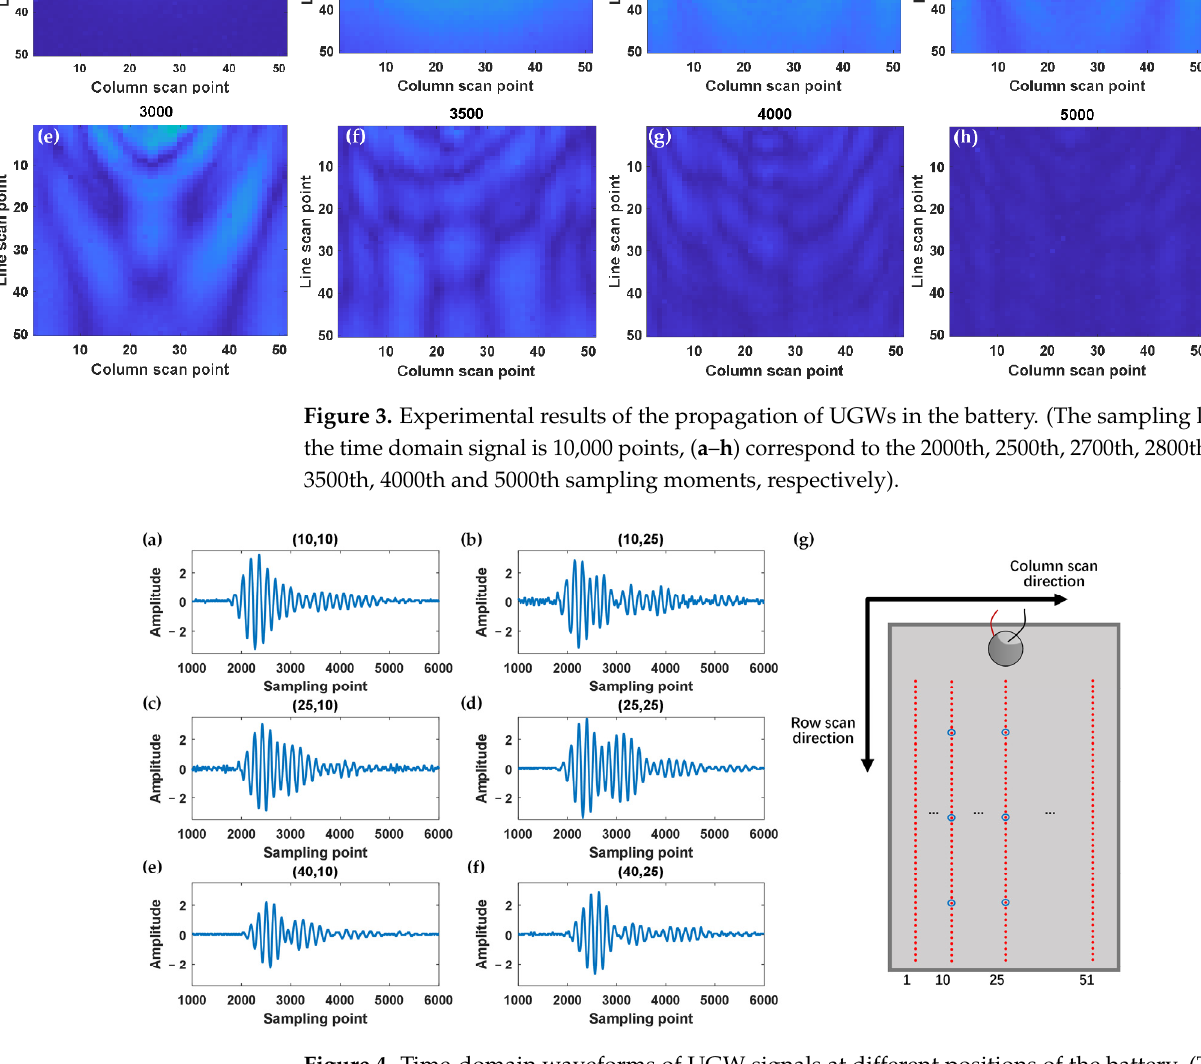
Figure 5. Energy spectrum of surface scanning UGW signal of lithium-ion battery. 4.2. Comparative Analysis of UGW Scanning Results of Different Battery SOC By scanning the B2 battery, several “point” parameters are extracted from the one- dimensional UGW time domain signal. Then the relationship between “point” parameters and battery SOC is analyzed. Figure 6 shows the results of the time-domain peak value of the signals changing with the battery SOC at point 33 and point 36 in the scanning area. For the same position, the time domain peak value of the UGW signal is basically con- sistent with the change trend of the battery SOC during the multiple charge/discharge processes of the battery. However, comparing the two positions, the trends of the “point” characteristic parameters at point 33 and point 36 are obviously different with the change of the battery SOC. The calculation results have greater randomness, while the two points